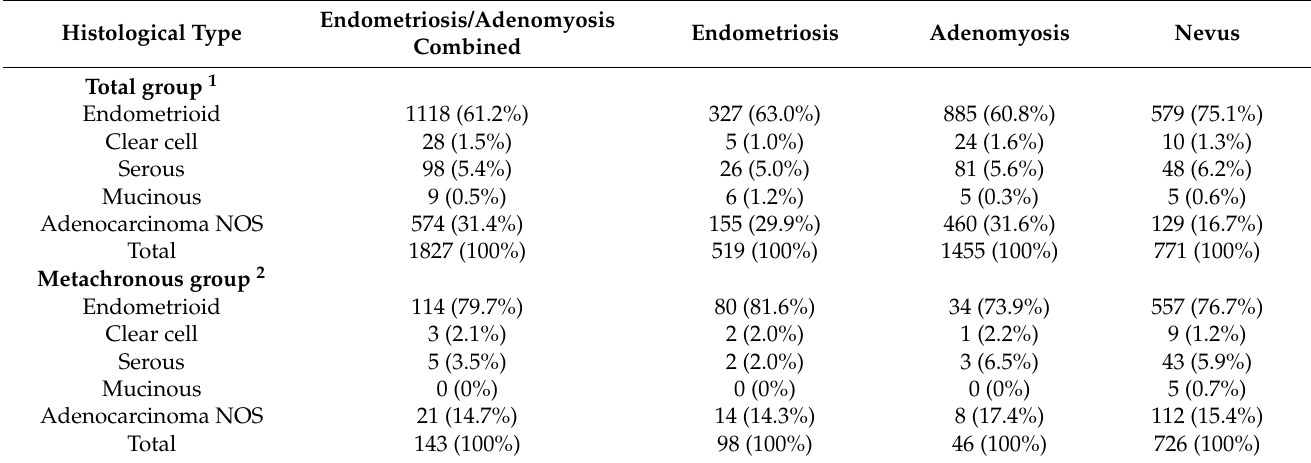
Table 4. Histological distribution with respect to cohort. Data are in numbers or percentages (%). Summed up numbers of endometriosis and adenomyosis are larger than the cases total because there were cases diagnosed with both endometriosis and adenomyosis. Metachronous group is defined as endometriosis, adenomyosis or nevus diagnosis at least a year before censoring date (autopsy, hysterectomy, or endometrial